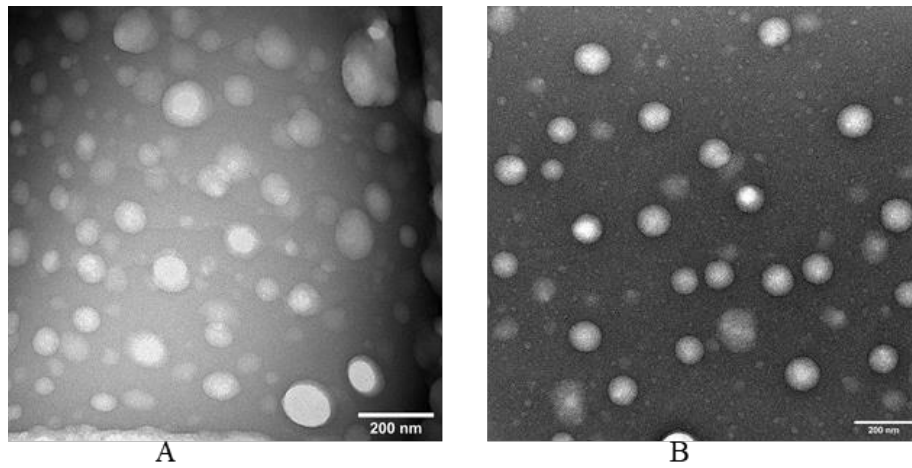
Figure 9. Electron microscopy images of ( A ) αTS -PTX-NLC and ( B ) αTS -PTX-PEG-NLC.